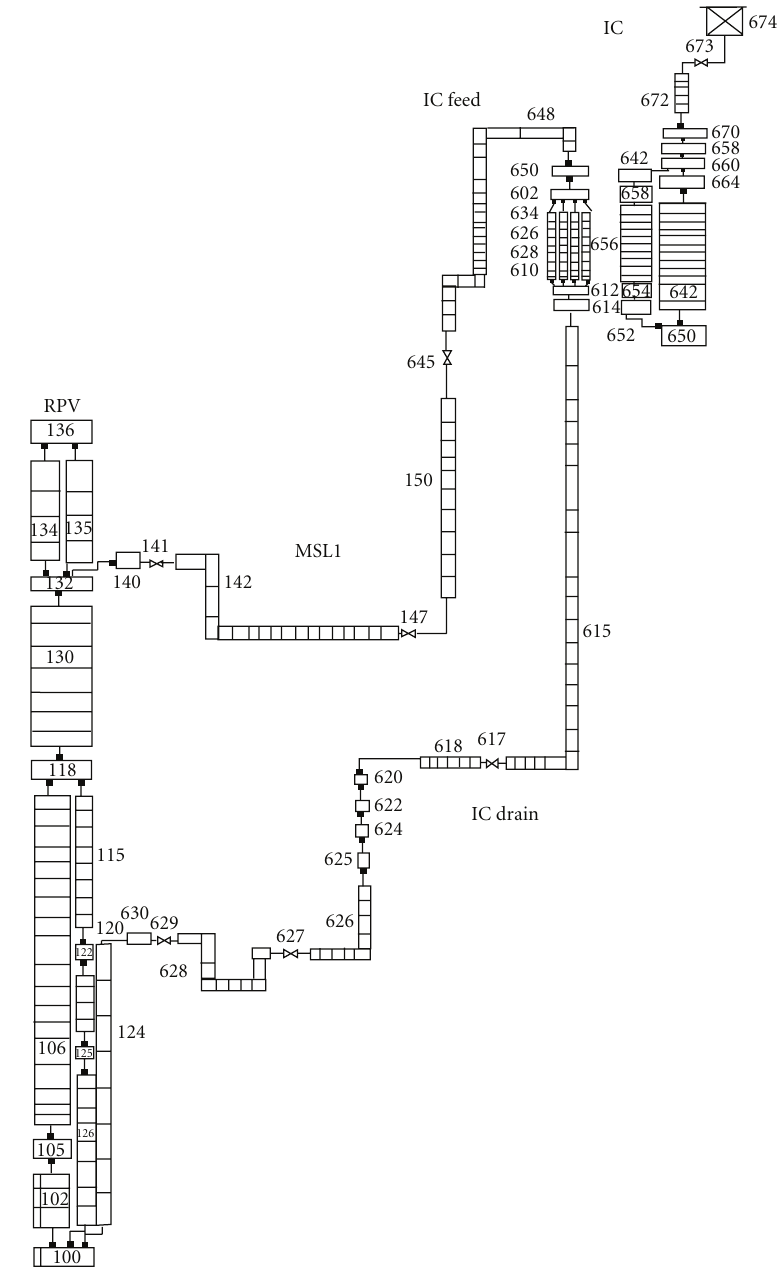
Figure 17: RELAP5 nodalization of IC of an SBWR case